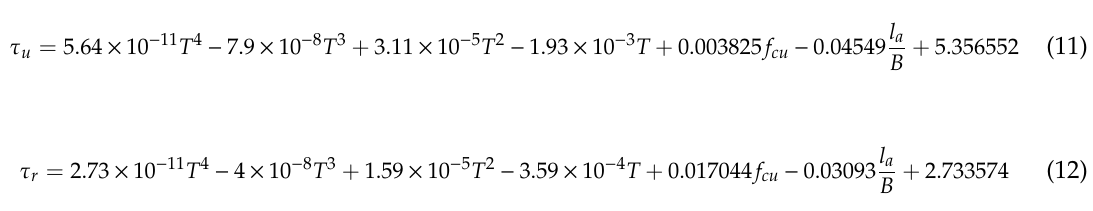
Figure 22. Energy dissipation factor ( a ) maximum temperature; ( b ) cooling method.